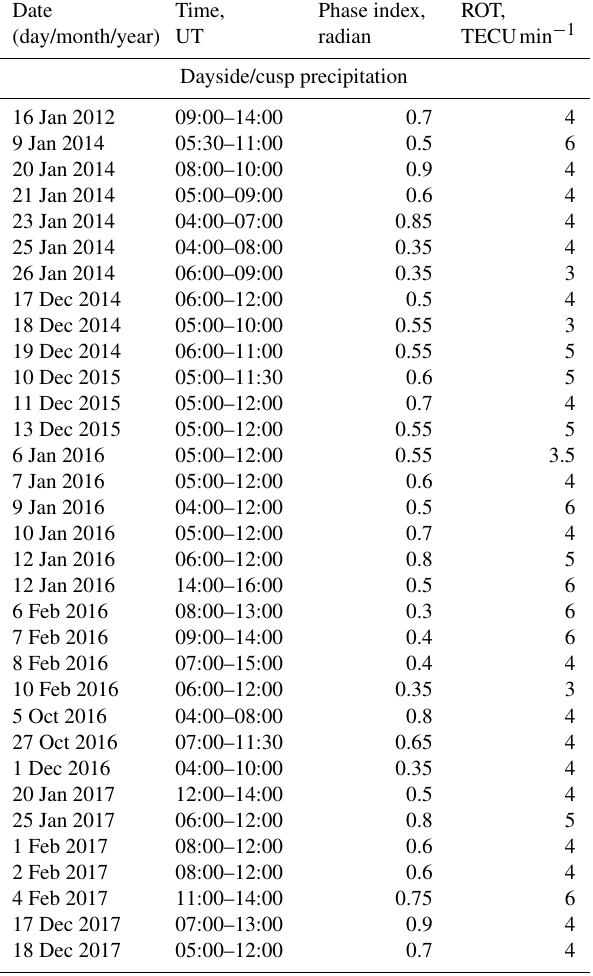
Table 2. The values of the phase scintillation index and ROT, de- termined from the GPS receiver at NYA station, and corresponding levels of the geomagnetic field disturbance ( (cid:49)X ) during substorm and substorm during PCPs